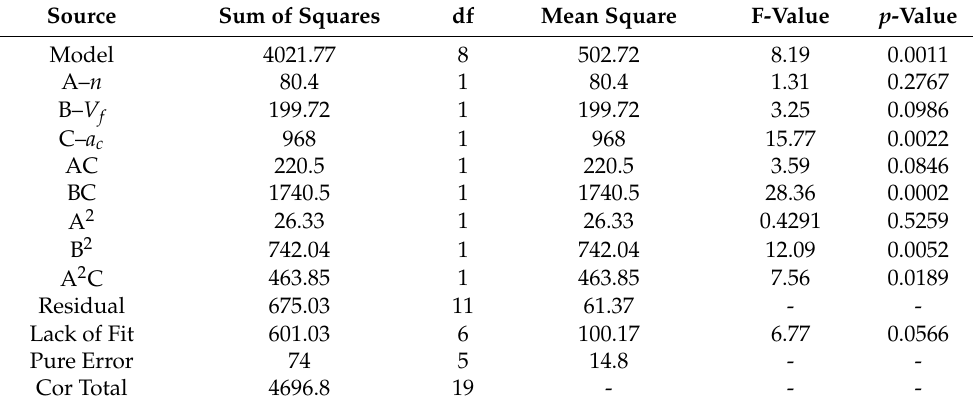
Table 5. The ANOVA results for the topographic diffusion angle β xoy are as follows: R 2 = 0.8563; adjusted R 2 = 0.7518; predicted R 2 = 0.5842; adeq precision = 9.5991. Notably, the overall regression of the model is significant at p = 0.0011. The F-value of 8.19 indicates that the model is primarily influenced by signal rather than noise, with only a probability of 0.11 of being affected by noise. Furthermore, all items in the table are significant except for A and A 2 , with p < 0.05 indicating high significance, 0.1 < p < 0.05 indicating significance, and p > 0.1 signifying